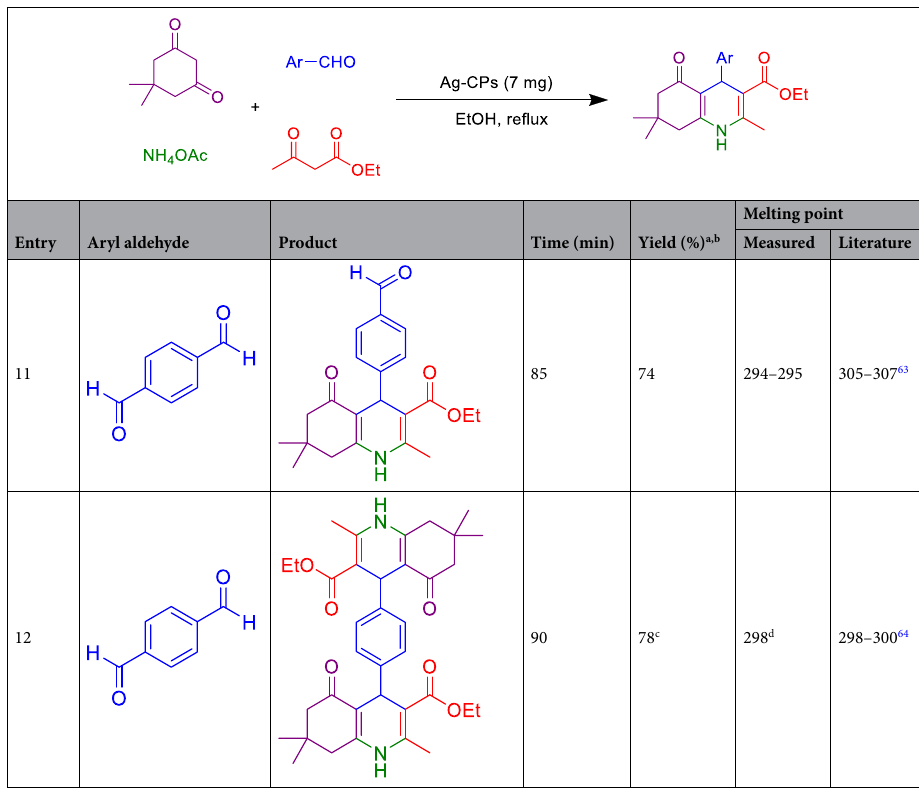
Table 2. Hantzsch synthesis of polyhydroquinoline derivatives in the presence of Ag–CP in EtOH at 80 °C. a Isolated yields. b Reaction conditions: Aromatic aldehyde (1 mmol), dimedone (1 mmol), ethyl acetoacetate